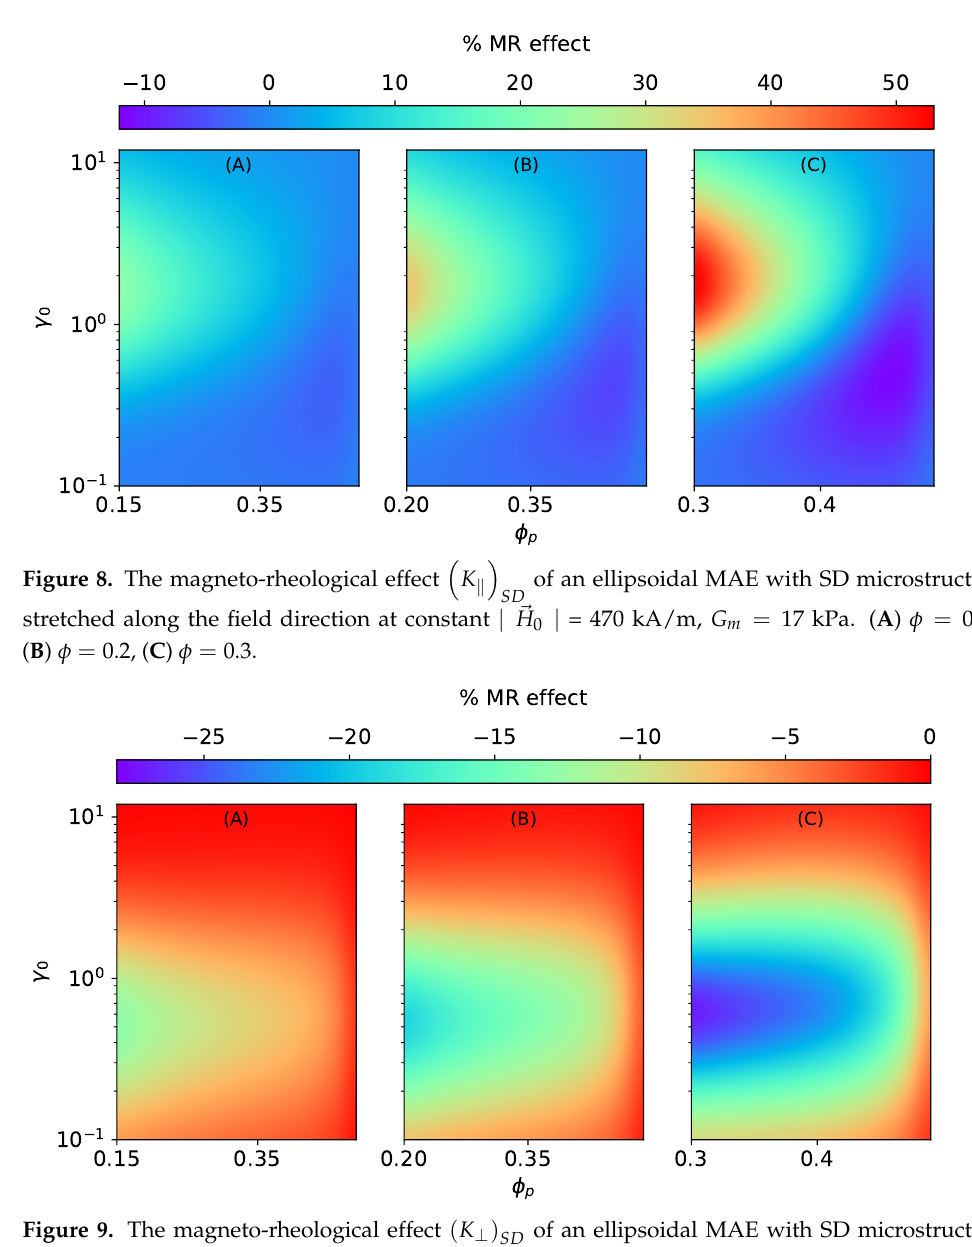
of an ellipsoidal MAE with SD microstructure SD